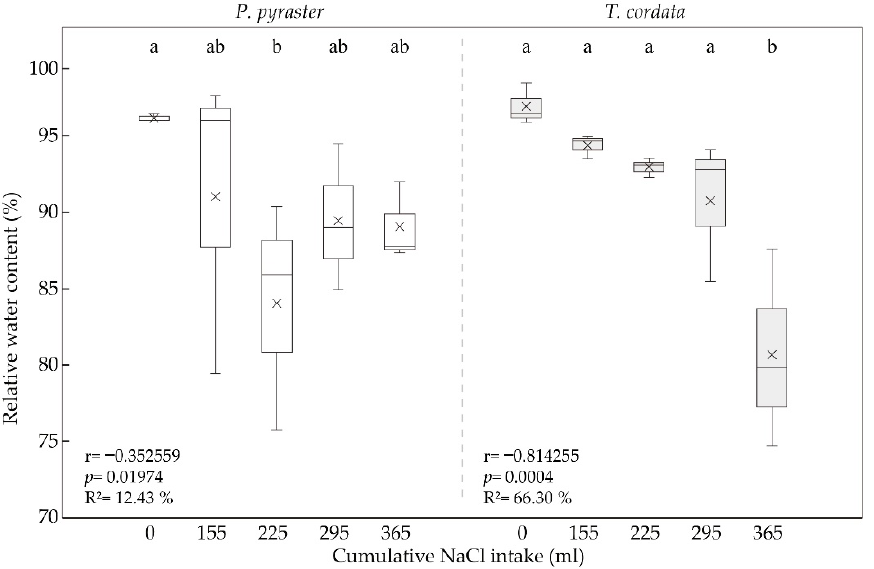
Figure 3. Box plot for the water potential of leaf tissues ( Ψ wl ) of the seedlings of P. pyraster and T. cordata measured at the beginning of the experiment (0 mL) and during the experiment when treated with 100 mM NaCl solution. Significant differences between measurements ( p ˂ 0.05) are indicated by different letters.